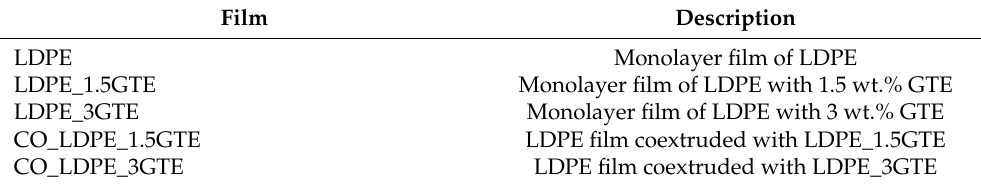
Table 1. Packaging films based on